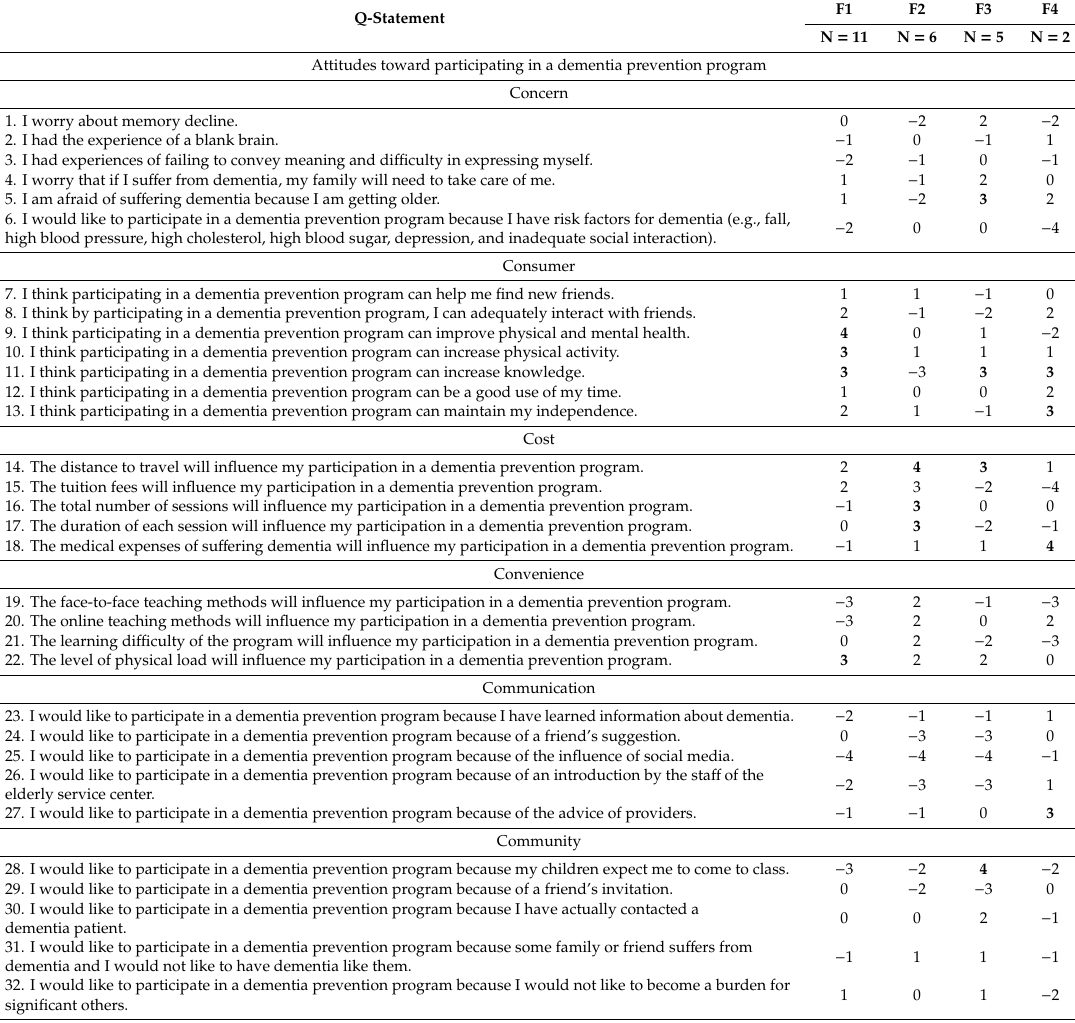
Table 3. Q-statements and factor arrays across the four